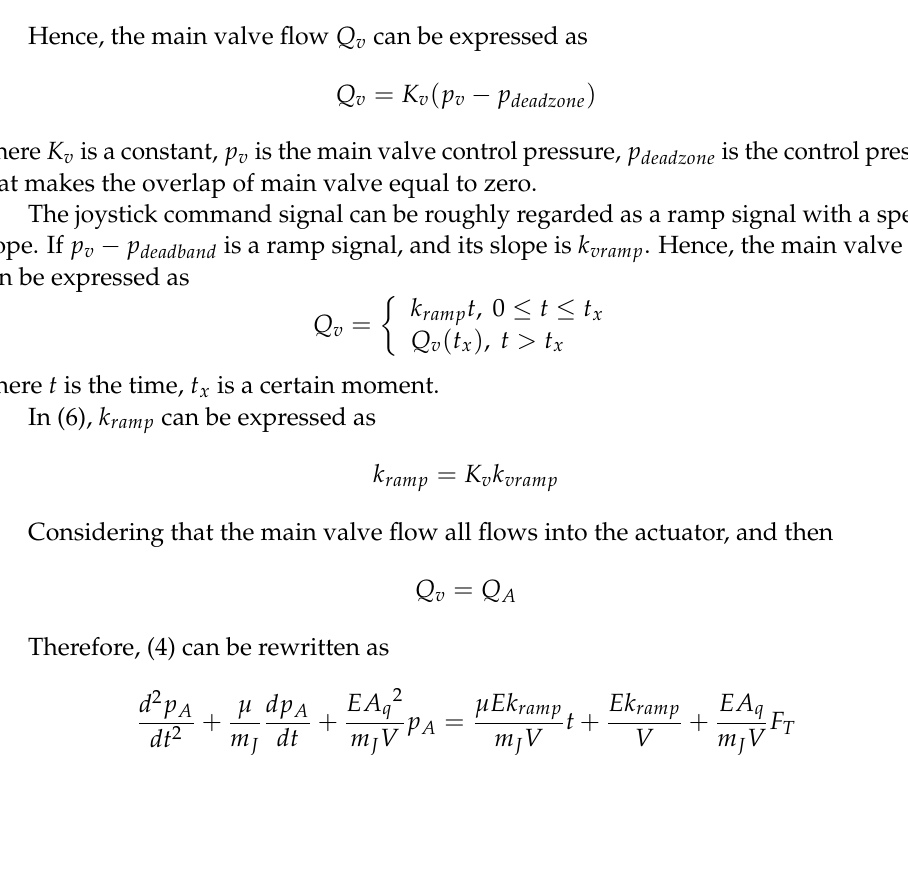
Figure 3. Main valve flow control characteristics.